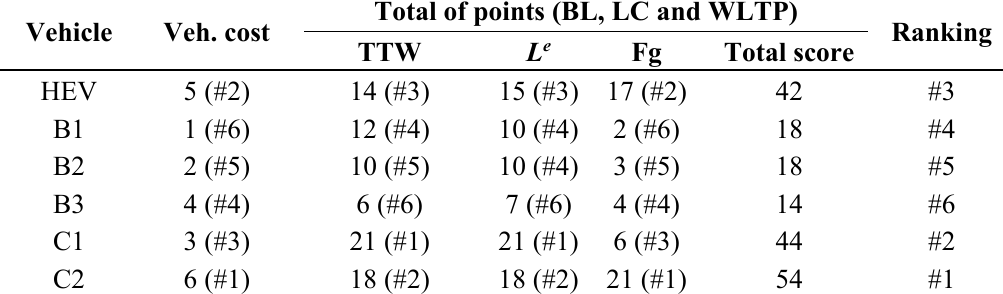
Table 12. Ranking of “best” solutions and total score attributed to the reference vehicles (ICEV and HEV) and optimal solutions for BL, LC and WLTP driving cycles, concerning the score approach. Vehicle Veh.